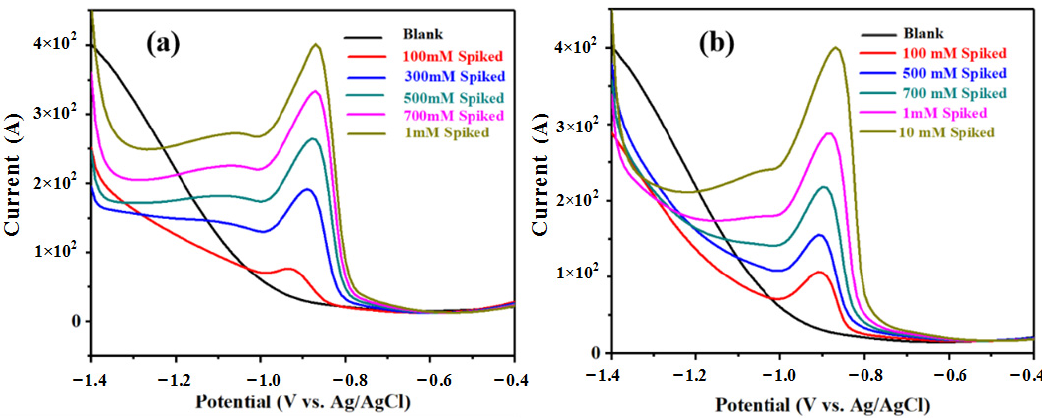
Figure 6. ( a ) Real sample analysis examined in spiked tap water with PB-PEDOT/LSG/GCE; ( b ) real sample analysis examined in spiked packaged drinking water with PB-PEDOT/LSG/GCE. Table 2. Analysis of Cd 2+ in tap water and packaged drinking water samples.